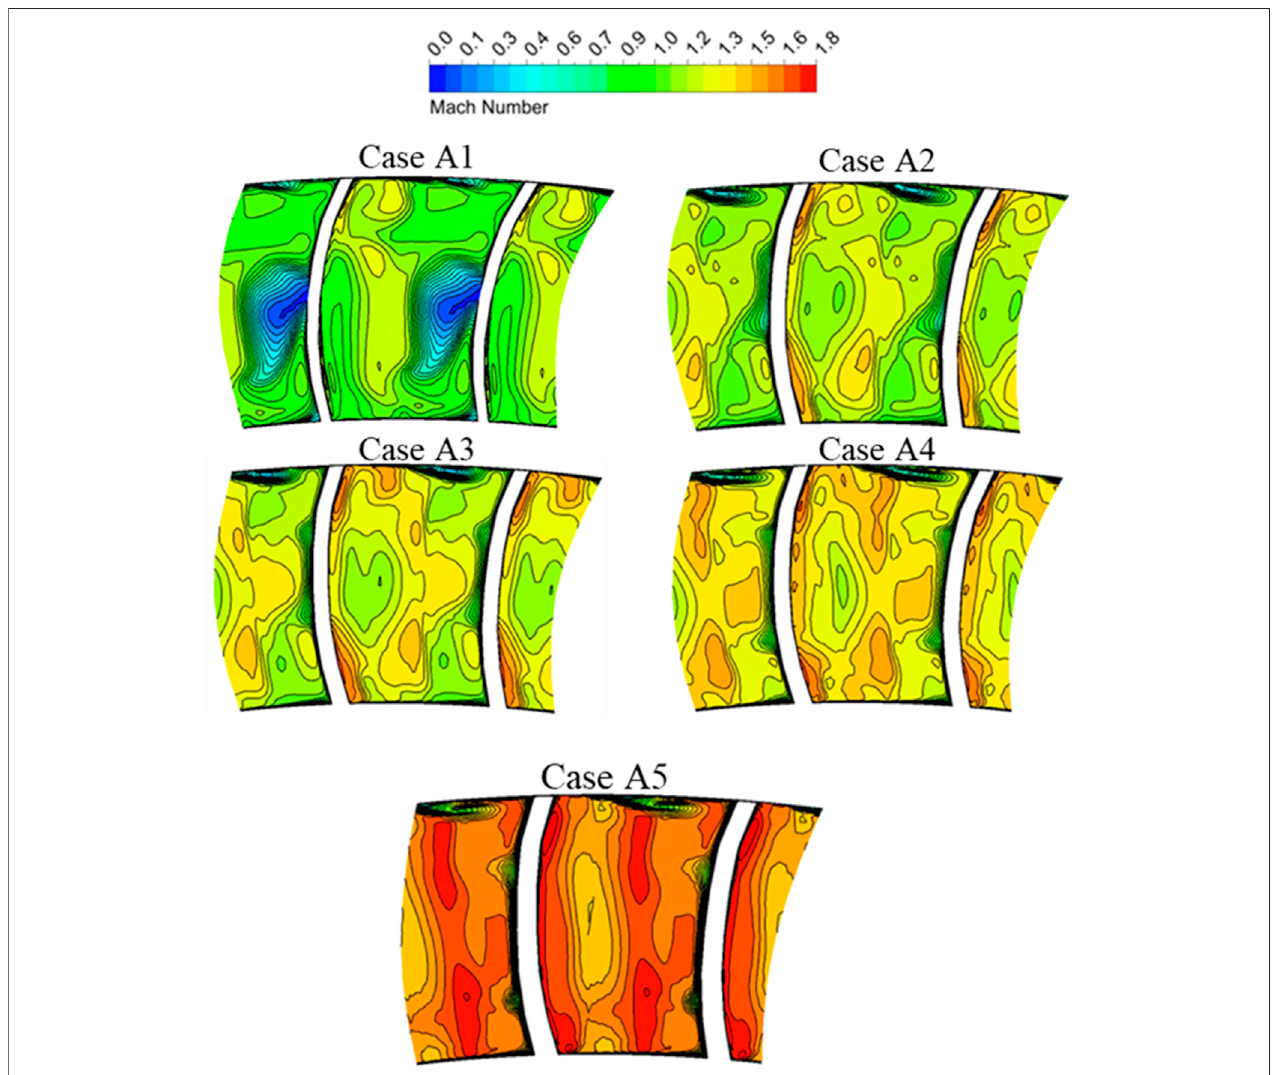
FIGURE 13 | Exit Mach number distribution of